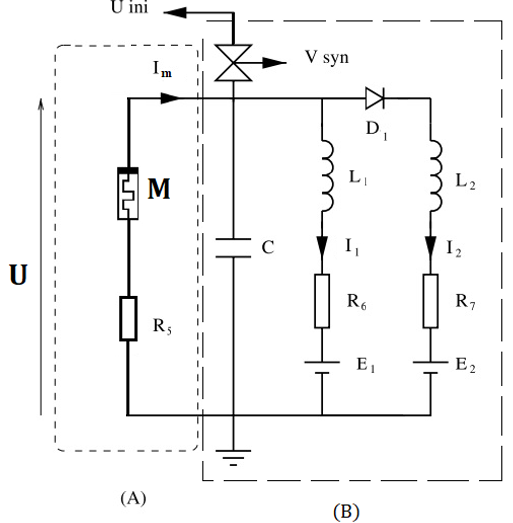
Figure 1. Diagram of the nonlinear circuit based on memristor. The circuit was modified from [27] by replacing the nonlinear element with the Au/Zr/ZrO 2 (Y)/TiN/Ti memristor. Modified with permission from Kazantsev V.B., neural networks; published by 2006 years.